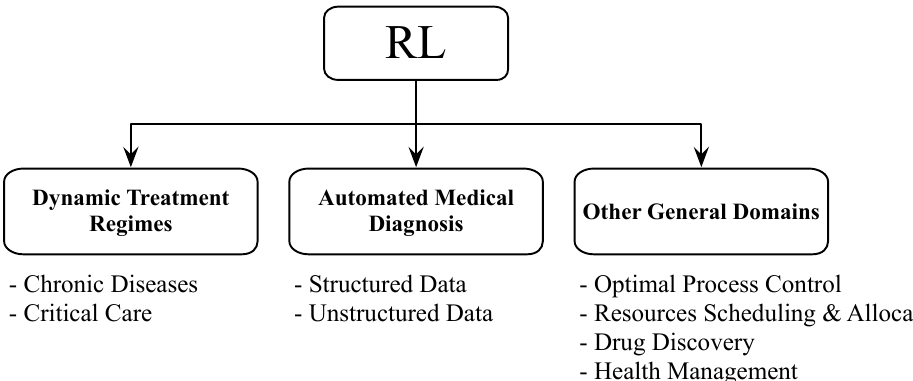
Figure 4. The outline of applications of RL in healthcare